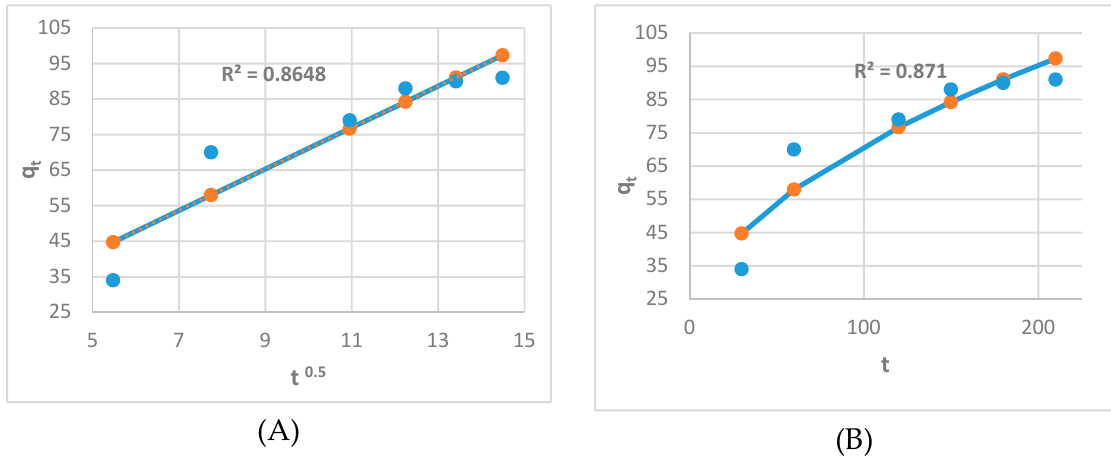
Figure 11. ( A ) linear Intraparticle diffusion kinetic model; ( B ) Nonlinear Intraparticle diffusion kinetic model.